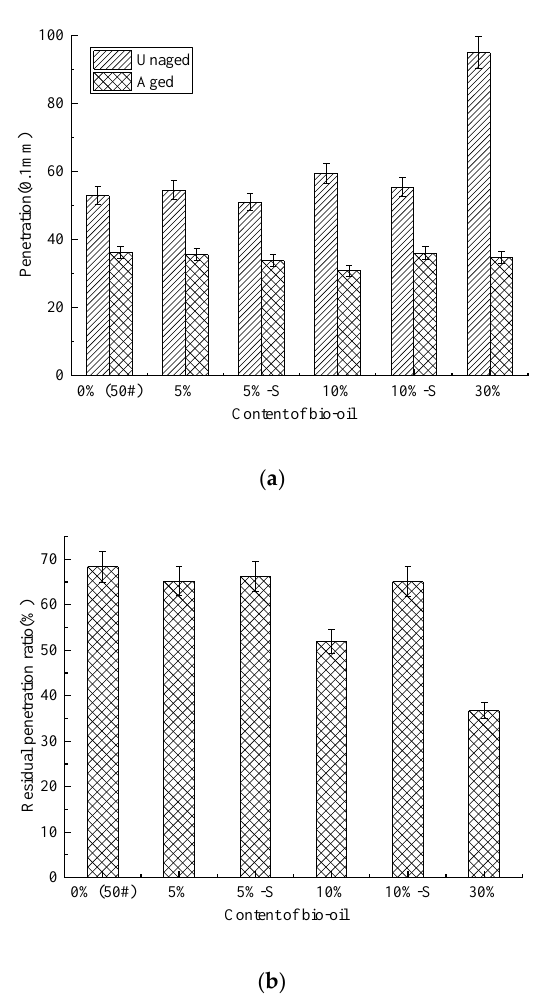
Figure 3. Penetration ratio and residual penetration ratio of unaged and RTFO (Rolling Thin Film Oven) aged bio-asphalt. ( a ) Penetration ratio; ( b ) Residual penetration ratio.